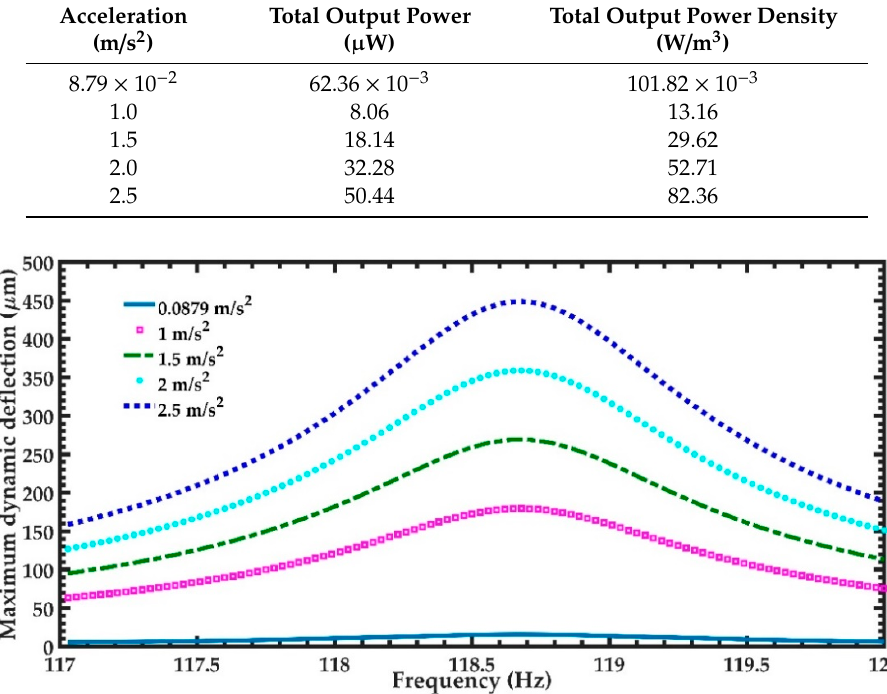
Figure 13. Maximum dynamic deflection of the nanogenerator considering four different accelerations in y -direction and a frequency range from 117 to 120 Hz.